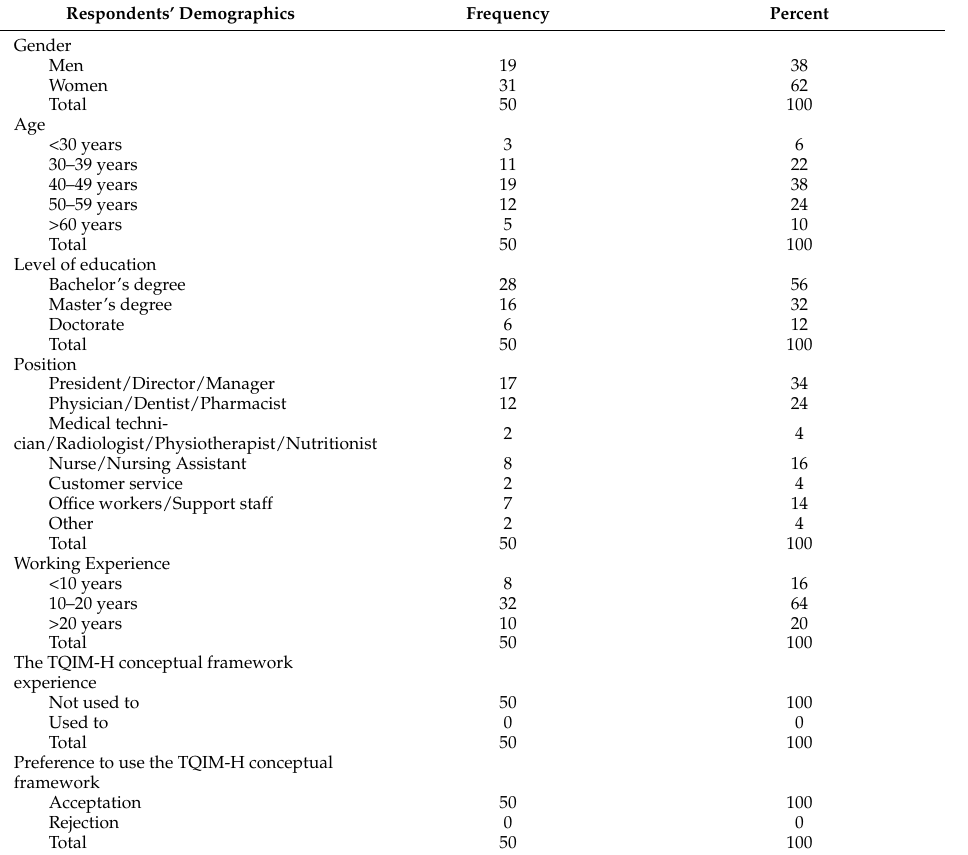
Table 5. General data of the sample